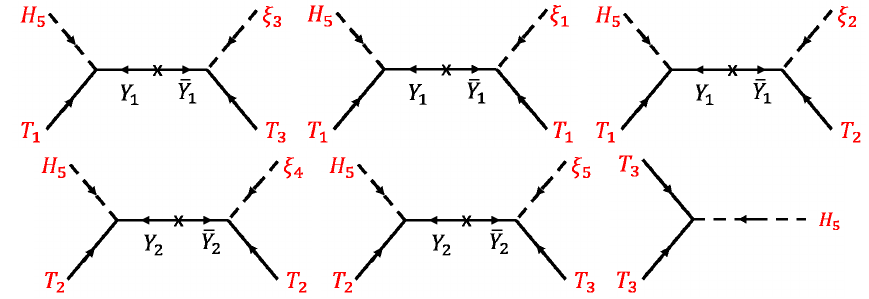
Figure 8 . Diagrams inducing effective operators for the up-type quark sector. The last diagram implies that the top quark mass originate from the renormalizable operator T